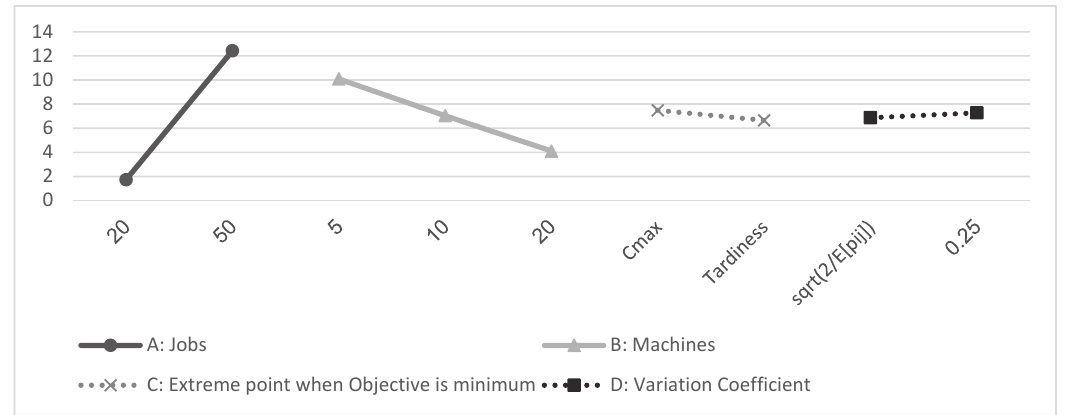
Fig. 10. Main effects plots for ratio E[Tardiness]/E[Cmax]